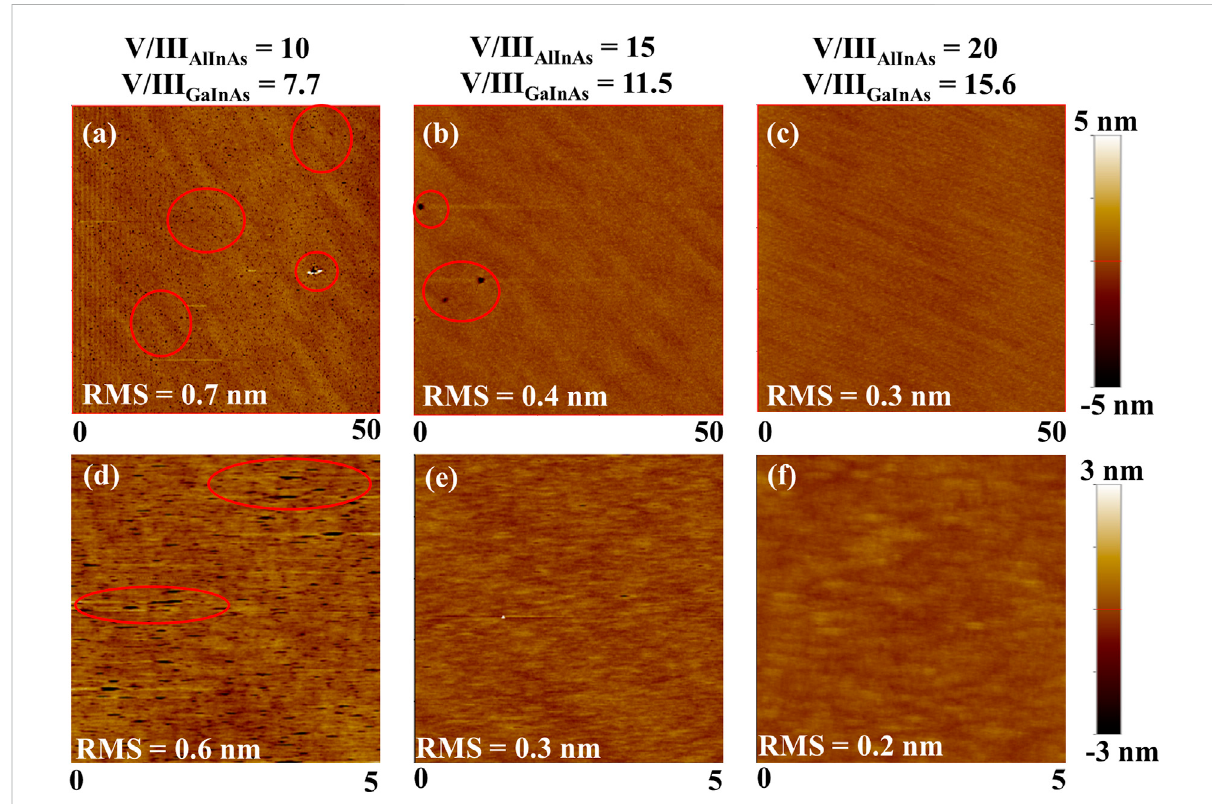
FIGURE 6 (A) Double crystal x-ray diffraction results for the fi nal optimal double InAlAs/InGaAs/InP superlattice structure; (B) AFM (1 μ m × 1 µm square area) image of fi nal optimal double InAlAs/InGaAs/InP superlattice.